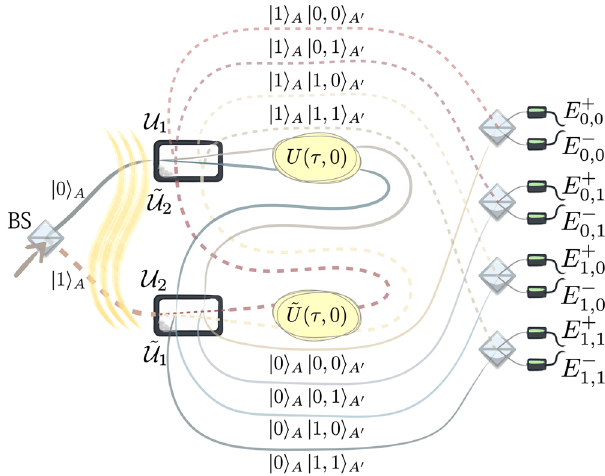
Fig. 2 Possible implementation of the extended two-point measurement scheme. A beam splitter (BS) creates a quantum superposition of the auxiliary state in j 0 i A , j 1 i A as represented by the upper (solid) and lower (dashed) paths in the left part of the fi gure, over which the initial state in Eq. (3) is prepared. Unitary operators U 1 ; 2 and ~ U 1 ; 2 couple the system with two additional internal registers A 0 , initially prepared in the state 0 ; 0 j i A 0 (for simplicity, unitaries U 1 ; 2 and ~ U 1 ; 2 are here imagined to produce binary results). Encoding pairs of system energy eigenstates ( n , m ) onto the registers A 0 leads to further subdivisions into different paths (middle part of the fi gure), which are recombined and measured only at the fi nal stage of the interferometer. The unitaries U 1 ; 2 and ~ U 1 ; 2 and the fi nal measurement replace the initial and fi nal projective measurements of E ð 0 Þ n and E ð τ Þ m in the TPM scheme in Fig. 1. When the auxiliary system is in the state j 0 i A ( j 1 i A ), the thermodynamic system is fi rst subjected to a unitary U ( ~ U ), then to 1 1 the thermodynamic process U ( τ , 0) [ ~ U ð τ ; 0 Þ ] within the time interval [0, τ ], and fi nally to a second unitary U ( ~ U ), see solid (dashed) paths in the (cid:2) (cid:3) 2 2 (cid:2) fi gure. Unitary U E ð 0 Þ of the n 1 encodes the energy of the eigenstates thermodynamic system into the fi rst register n ; 0 j i A 0 ( n = 0, 1) of the auxiliary system, while unitary U 2 encodes the energy of the eigenstates (cid:2) (cid:3) (cid:2) E ð τ Þ into the states n ; m j i A 0 ( m = 0, 1) of the second register. The four m possible outcomes are indicated as four solid paths (bottom part of the fi gure), each labelled as j 0 i j n ; m i A 0 . Similarly, the unitaries ~ U and ~ U A 1 2 encode the energies of the thermodynamic system before and after the quench in the second and the fi rst register respectively, when the auxiliary system is in 1 j i A (four dashed paths labelled as 1 j i A m ; n j the fi gure). This enables to maintain the coherence of the auxiliary system ’ s states until the end of the interferometer. There, the states 0 j i A n ; m j i A 0 are interfered pairwise through further BSs, and measured. The results of the fi nal measurements over the system A in the diagonal basis f ± j i A g are indicated by the symbols E ± n ; m